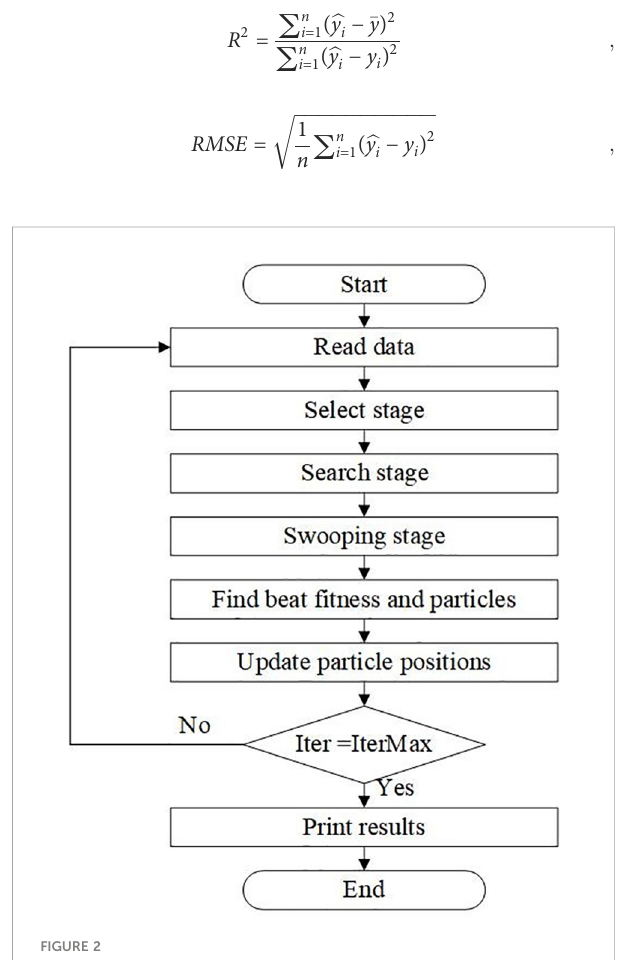
FIGURE 2 Flow Chart of BES